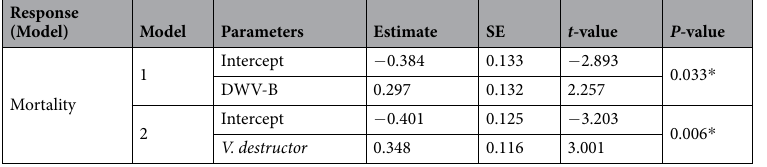
Table 1. Best models explaining overwinter colony workforce mortality using GLMs and QAICc for model selection. Model 1: DWV-B as explanatory variable ( r 2 = 0.16), Model 2: V. destructor infestation as explanatory variable ( r 2 = 0.25). Viral and Nosema spp. prevalence was based on 15 individuals per colony while V. destructor infestation was estimated on a sample of 150 individuals per colony.